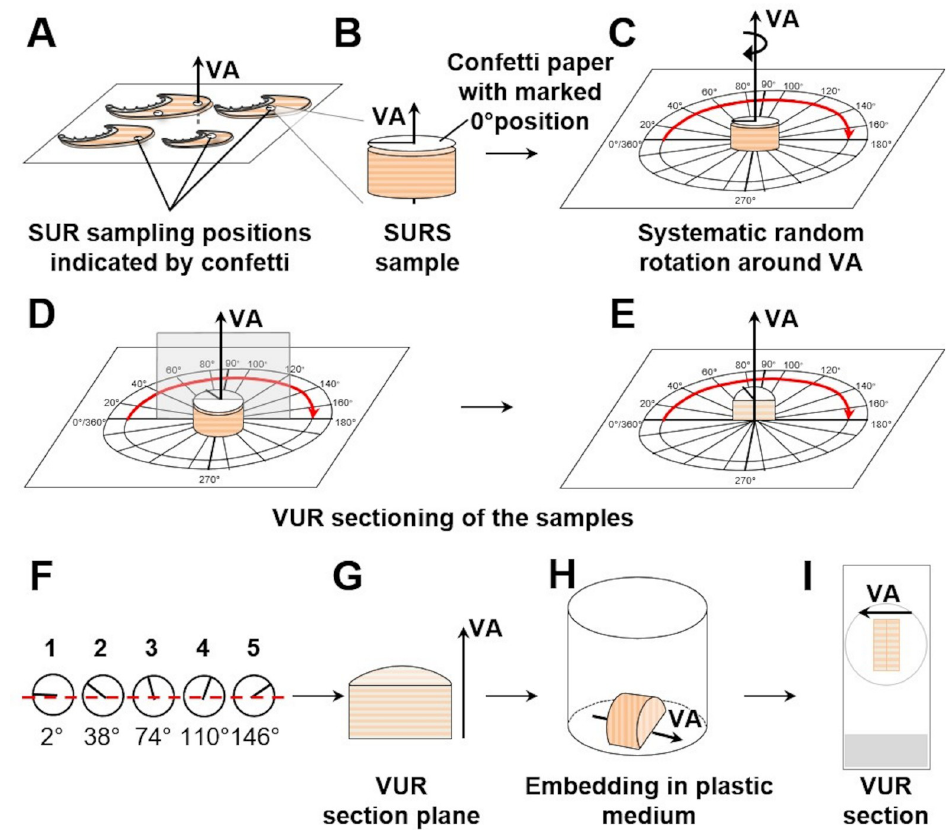
Fig 10. Generation of VUR sections of a SUR sampled gill filament sample. A. SUR sampling positions on the GF are marked by confetti paper. The vertical axis (VA) is indicated. B. SURS sample excised with a biopsy punch. The orientation of the sample relative to the gill is marked by a black line on the confetti paper (0˚-180˚-line). C. The sample is placed on an equiangular circle, corresponding to the 0˚-180˚-mark on the confetti paper. D-G. The first SURS specimen is randomly rotated around the VA by an angle between 0˚ and 36˚, determined using a random number generator (here: 2˚). The following four samples are systematically rotated around their VA in a predefined rotation interval of 36˚ (here: 38˚, 74˚, 110˚, and 146˚). The samples are sectioned at the corresponding positions (parallel to the VA). H. The samples are embedded in plastic medium ( e . g ., GMA/MMA), maintaining the orientation of their VUR section surfaces, the VA is still identifiable in light microscopy. I. The resulting histological sections are VUR sections, used for analysis of the surface area densities of the secondary gill lamellae in the gill filaments (S V(SL/ GF) ), as described in Section 13